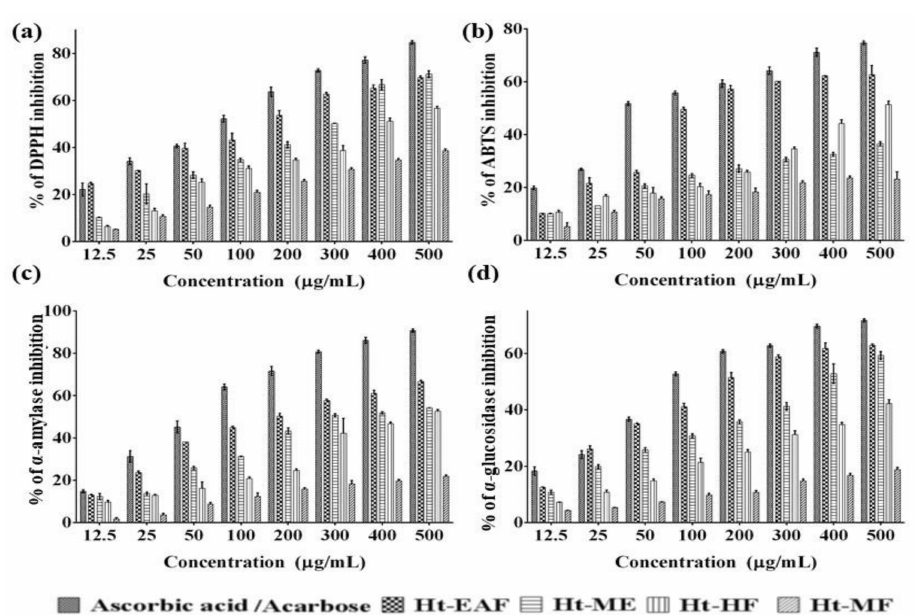
Figure 1. ( a ) % of DPPH ( b ) ABTS radical scavenging ( c ) α -amylase and ( d ) α -glucosidase inhibition activity of different fractions and methanolic extracts of H. tuberosus . The values are expressed as mean ± standard deviation of three independent